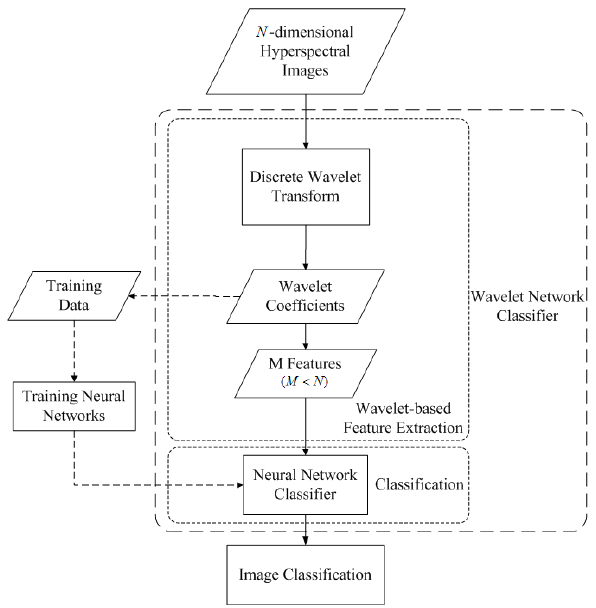
Figure 1. Comparison between neural networks with WFE and wavelet networks